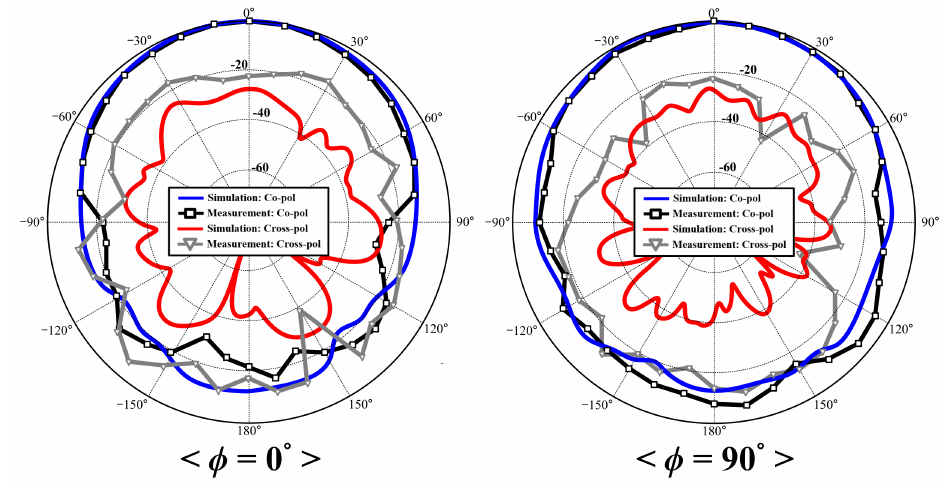
Figure 5. Measured antenna radiation